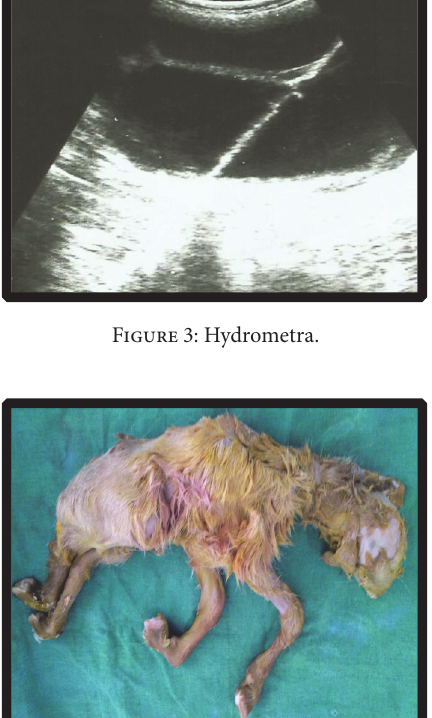
Figure 4: Full-term dead fetus removed by cesarean